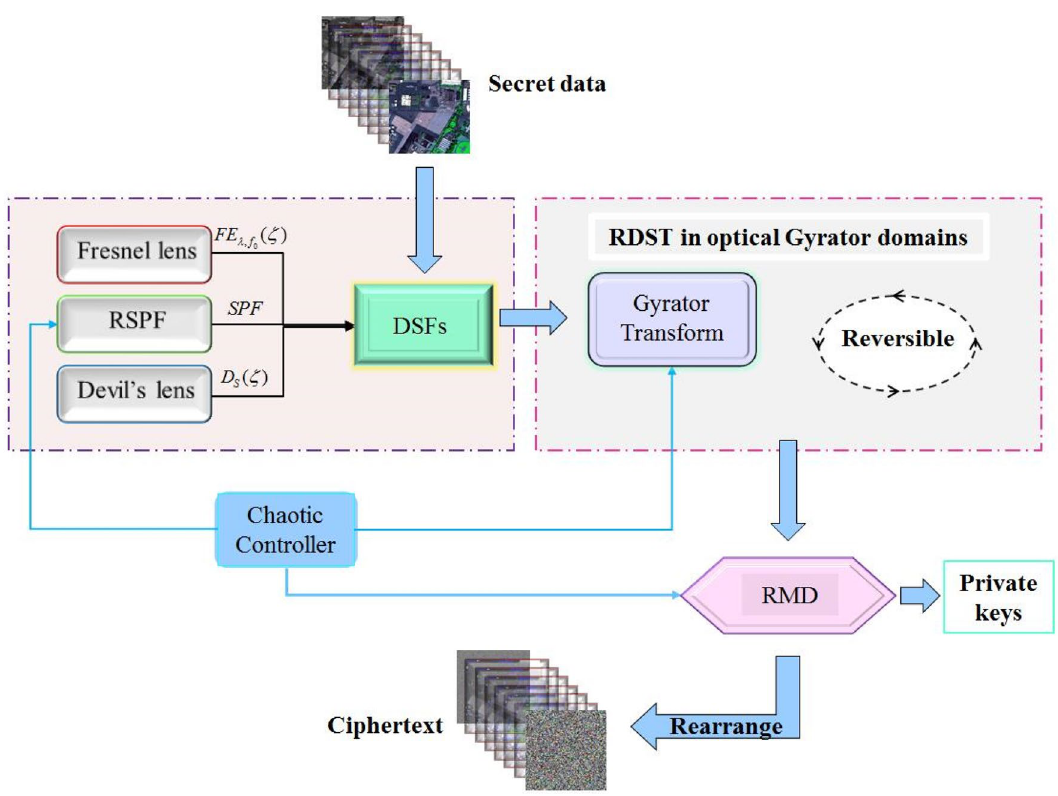
Figure 3. The flowchart of the proposed cryptosystem for multiple